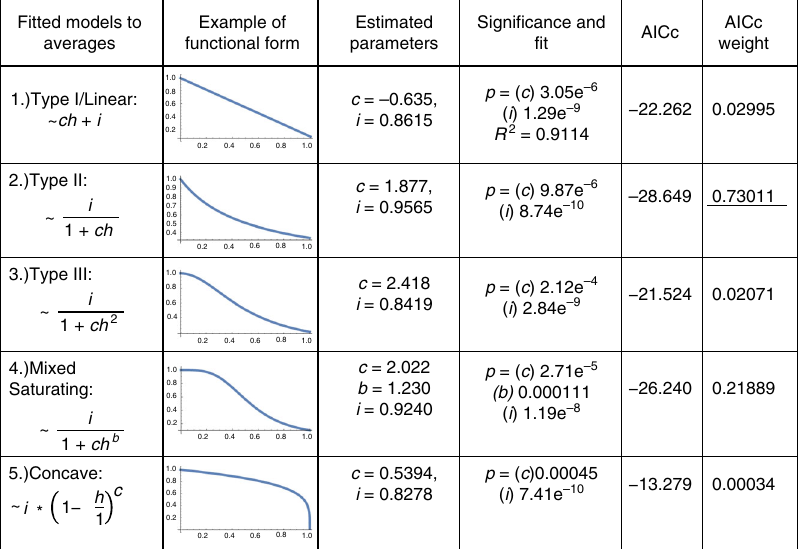
Fig. 1 Curve fi tting the fi ve candidate response models. Describing the results of the curve fi tting to the fi ve candidate response models for v ( c , h ): Type I/ Linear, Type II, Type III, Mixed Saturating, Concave. Here h represents the level of herbivory. The parameters c and b determine the shape of the curve and i is the intercept. Equation representations of each model are given along with a pictorial example of each model. The Type II functional response has the highest Akaike Information Criterion weight of 0.73011